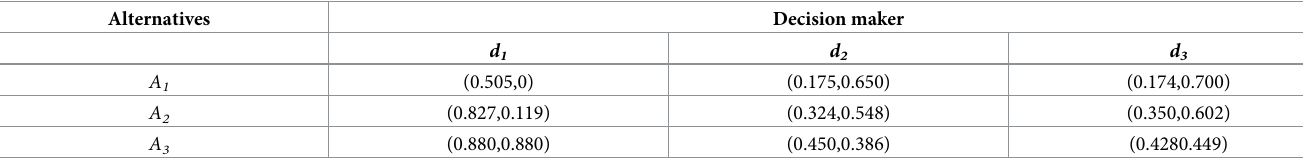
Table 9. Three weighted (on attributes) scores